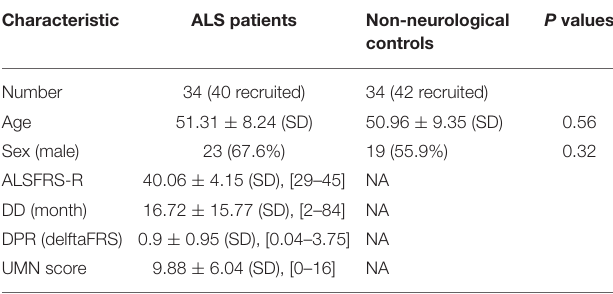
TABLE 1 | The demographic and clinical profile of study